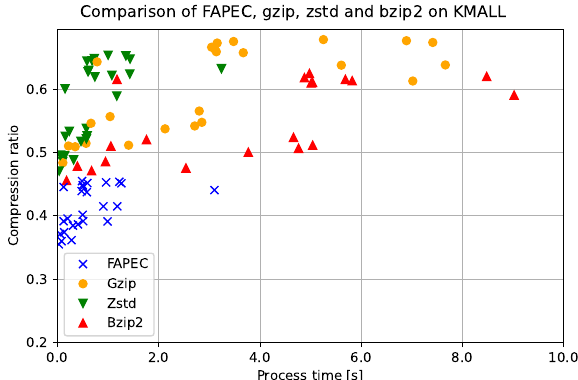
Figure 12. Comparison of lossless compressors showing that FAPEC performs better both in time and ratio than gzip , Zstd and bzip2 on KMALL files.